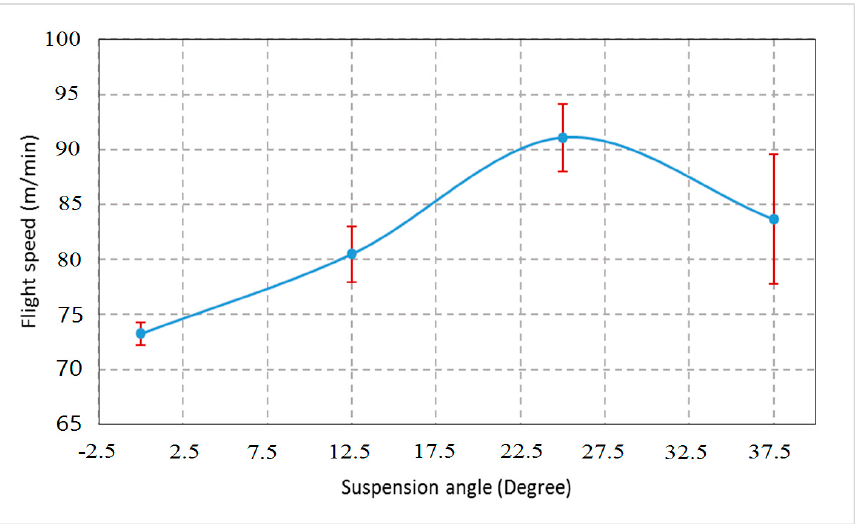
Figure 22. Effect of RPW suspension angle on flight speed of RPW under a controlled atmosphere with temperatures of 30 °C and RH of 35%.